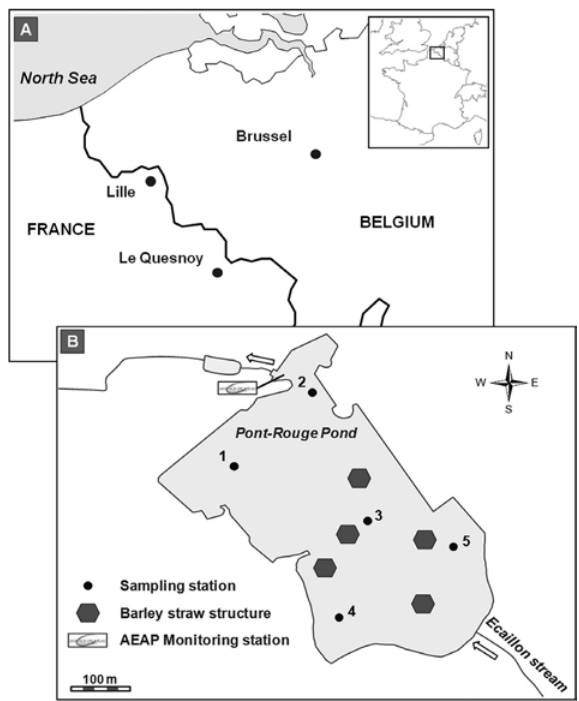
Fig. 1. Location of the city of Le Quesnoy (A) and map of the Pont-Rouge Pond including the location of sampling stations, barley straw structures and the monitoring station